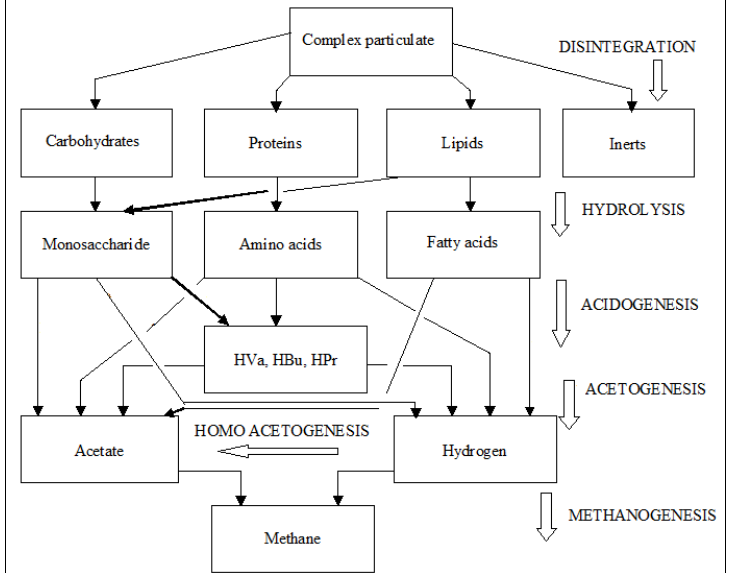
Figure 3. The anaerobic microbiological process diagram [31].